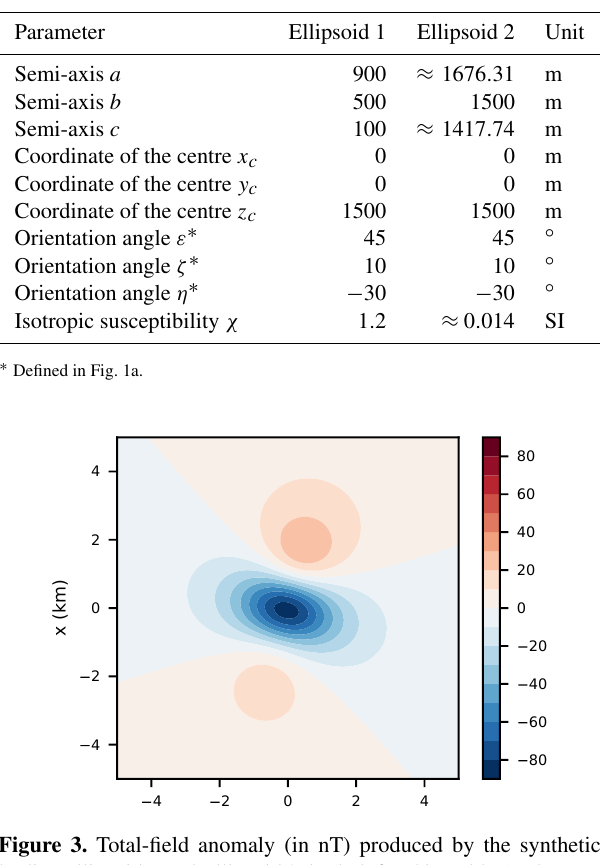
anisotropy. The differences are shown in Fig. 4c. These re- sults confirm numerically what was pointed out by Clark (2014): confocal ellipsoids with properly scaled isotropic susceptibilities, no remanence and the same magnetic mo- ment produce different magnetic fields at the same external points, unless the inducing field happens to lie along one of their